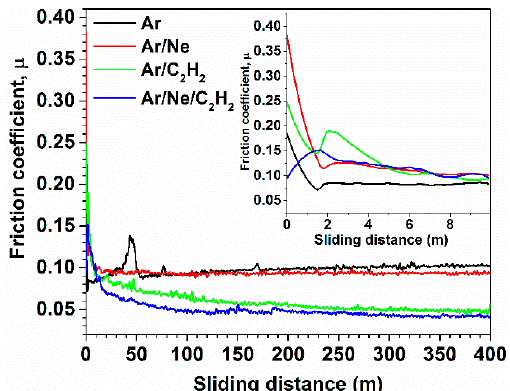
Figure 7. Friction coefficient variation on sliding distance of 400 m, under 10 N normal load, with sapphire ball counterpart versus coatings.